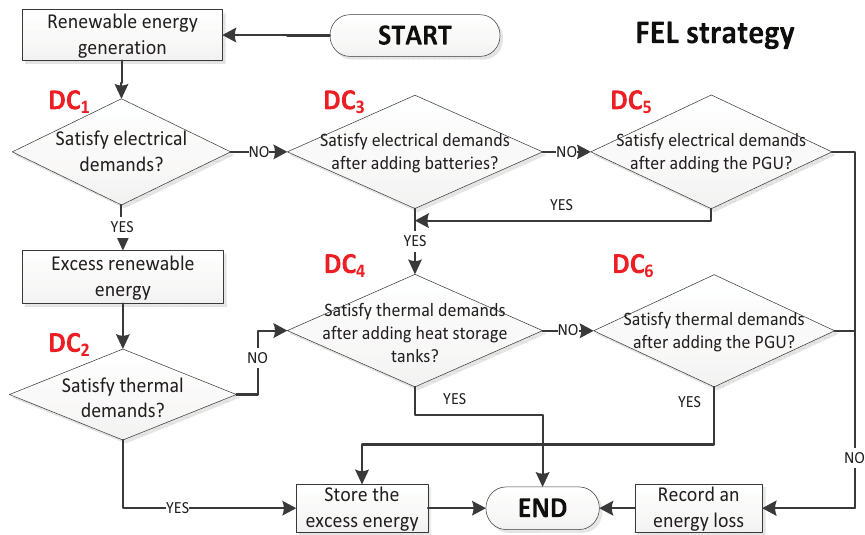
Figure 5. Flowchart of the following electric load (FEL) operation strategy. DC : discriminant